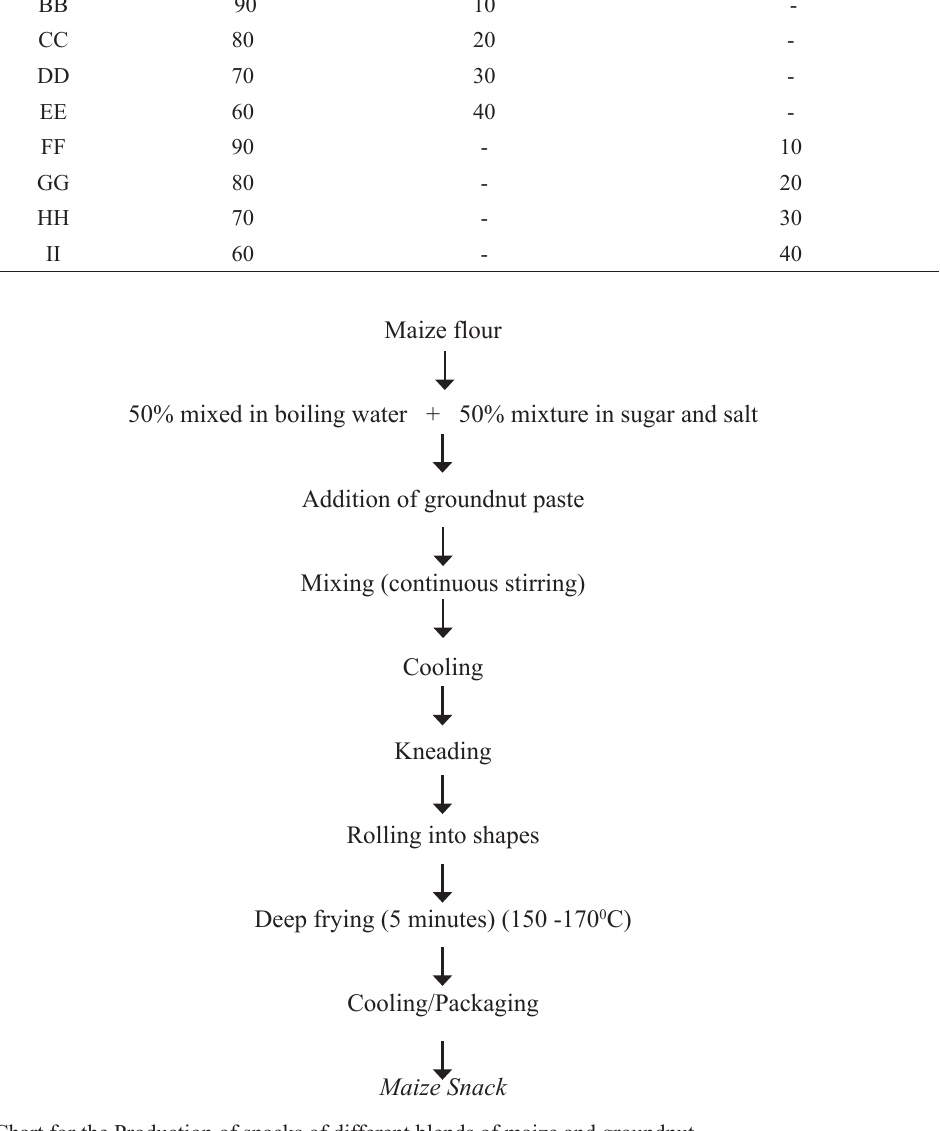
Figure 1: Flow Chart for the Production of snacks of different blends of maize and groundnut.